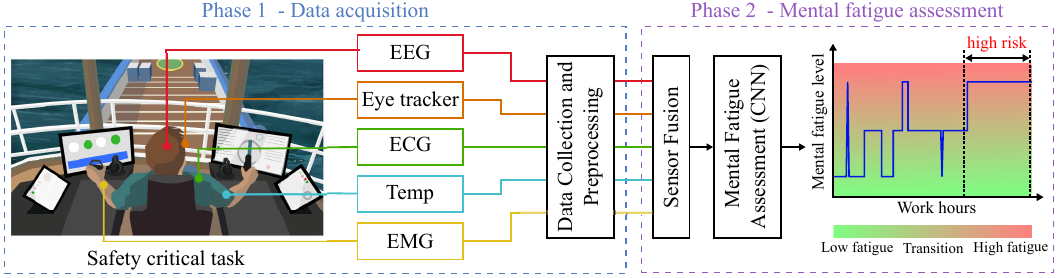
Figure 1. Proposed concept for fatigue